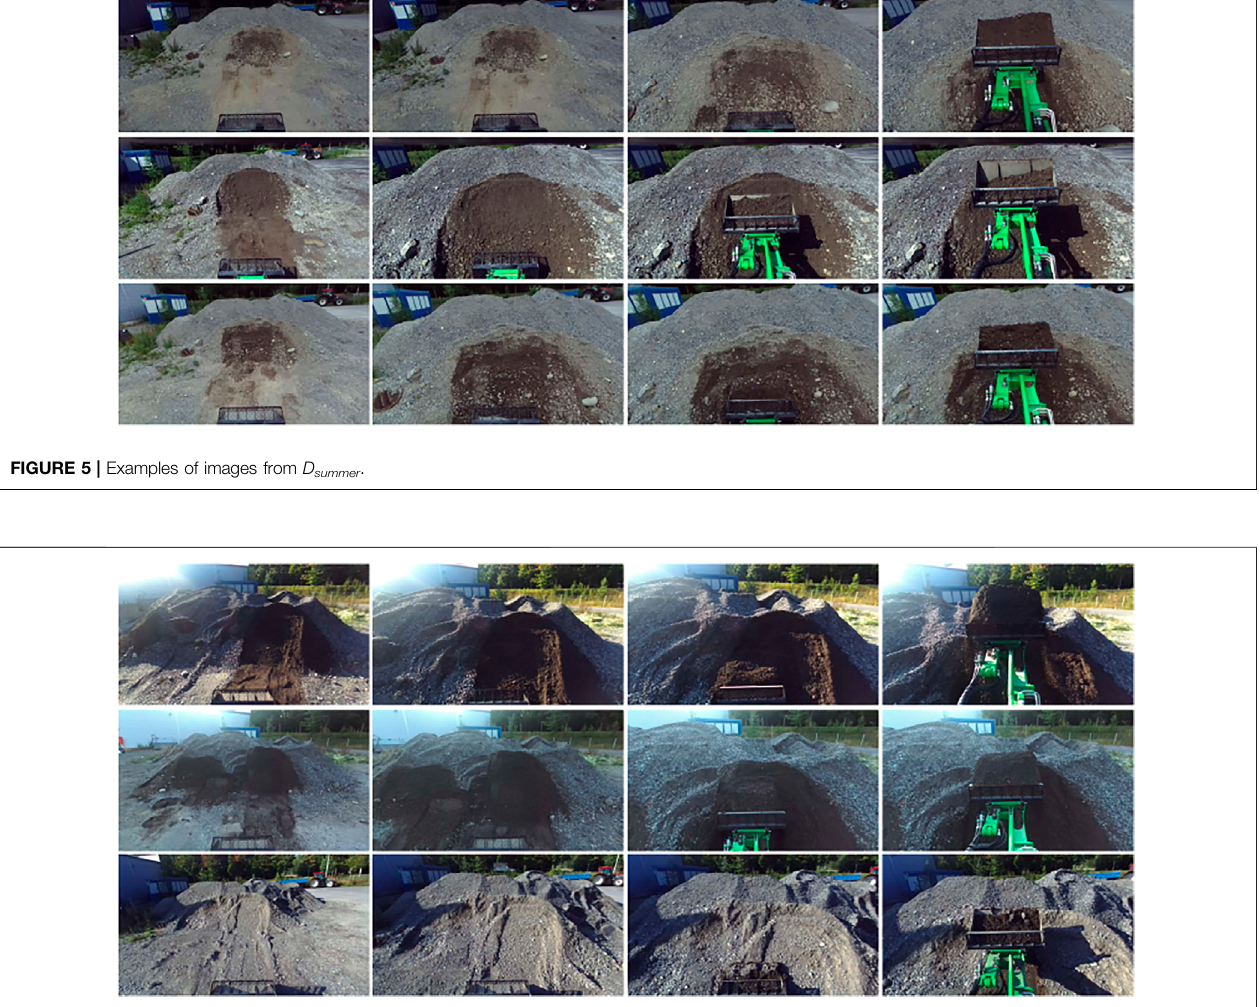
FIGURE 6 | Examples of images from D autumn